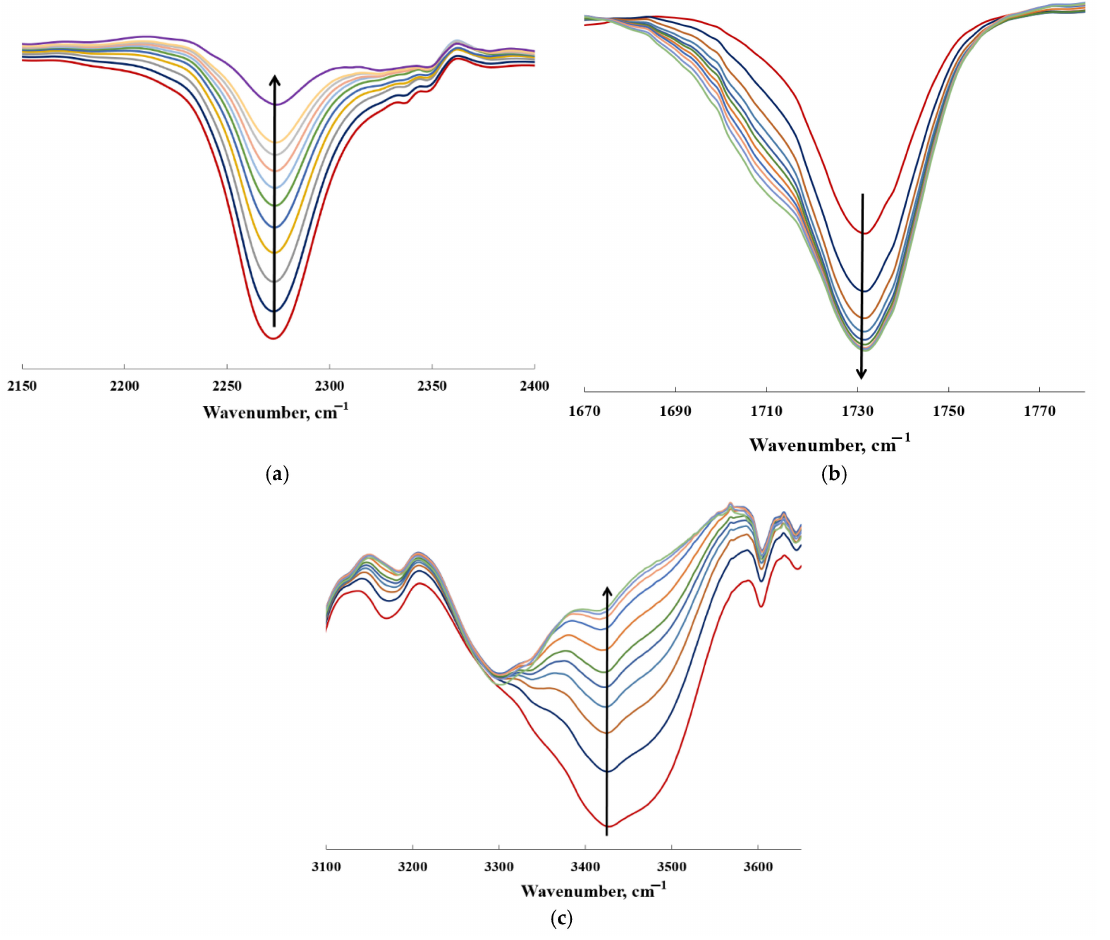
Figure 7. FTIR spectra measured during the interaction of AEBA with TDI. The cursor indicates changes in the spectrum consumption of isocyanate groups ( a ), formation of urethane groups ( b ) and consumption of hydroxyl groups ( c ) from the beginning of the reaction (zero minute) to its end. The time interval between measurements was 10 min. T = 25 ◦